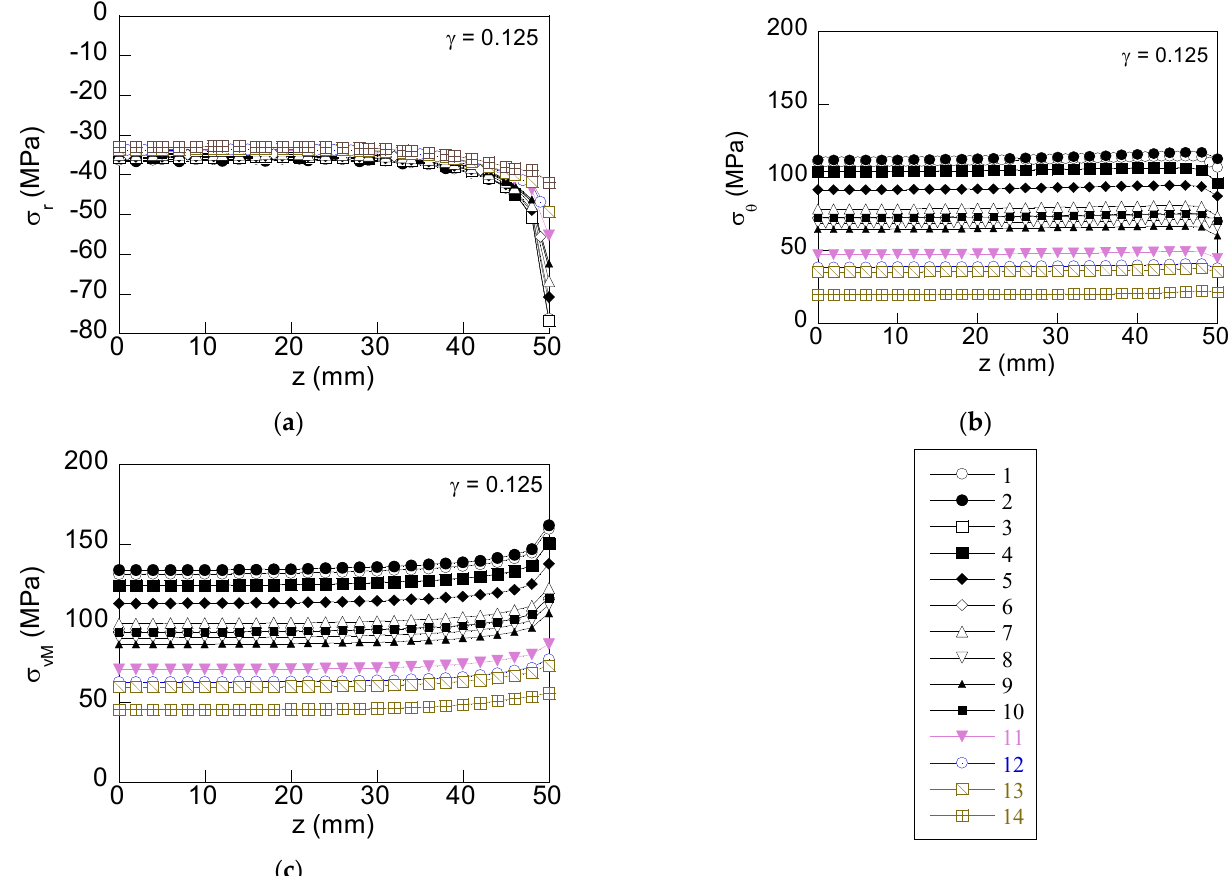
Figure 12. Axial distributions at the interface shaft-hub of: ( a ) radial stress, ( b ) tangential stress, and ( c ) von Mises stress for diverse materials of the contact ring (  = 0.125). ( c ) von Mises stress for diverse materials of the contact ring ( γ =